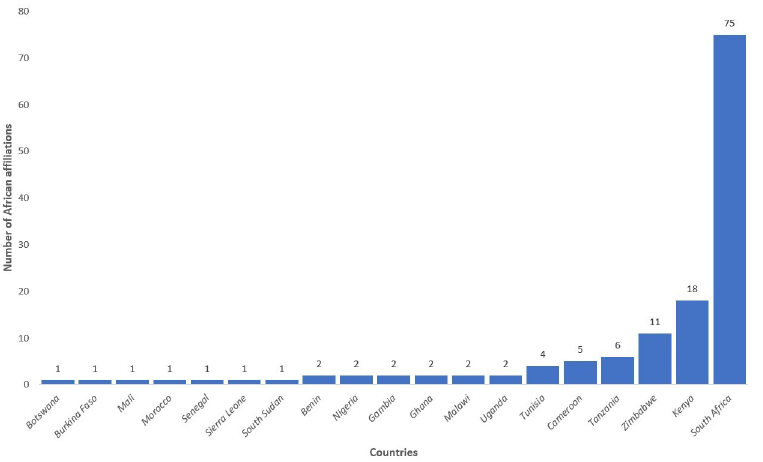
Fig 5. The number of publications with African institutional affiliated last authors by country of affiliation.